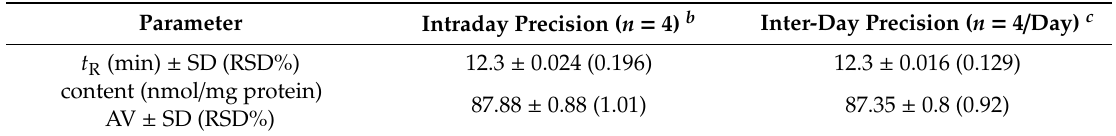
Table 2. Validation of the N 2 -(5-fluoro-2,4-dinitrophenyl)- l -valine amide (L-FDVA) derivatization of the MG-H1 adduct with intraday and inter-day precision values determined for MG-H1 in enzymatic hydrolysates of glycated BSA a .